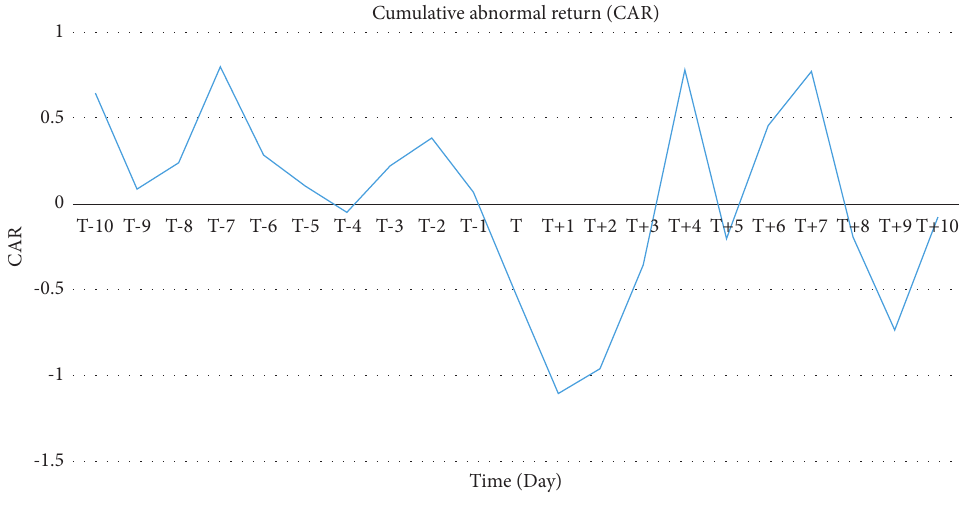
Figure 2: Fluctuation chart of cumulative abnormal return. Table 4: T test of abnormal return